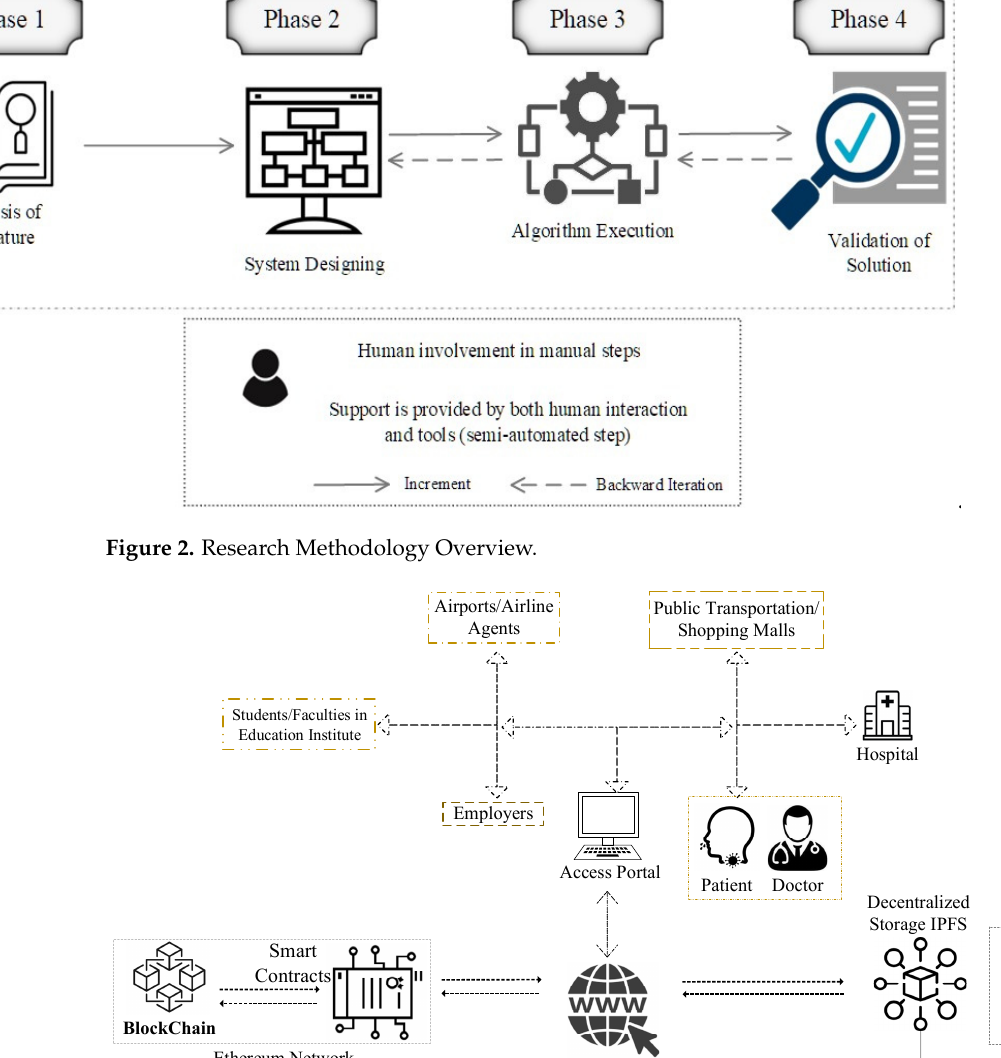
Figure 2. Research Methodology Overview.